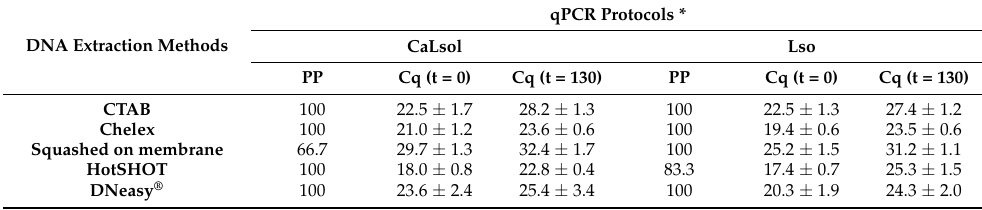
Table 7. Comparison of qPCR results by CaLsol and Lso protocols before (t = 0) and after 130-weeks of storage (t = 130) of ground samples in each method.